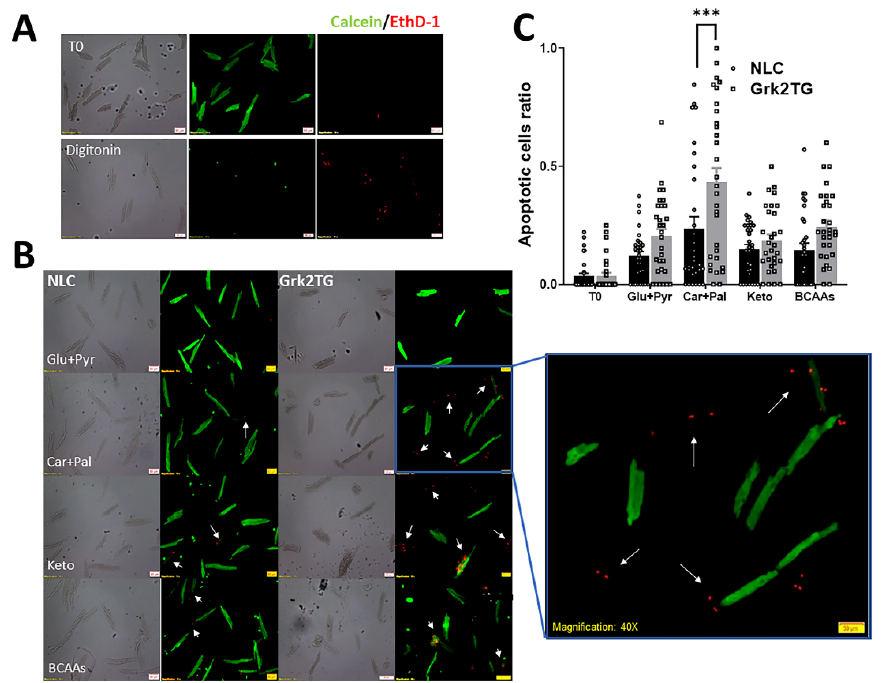
Figure 1. Upregulation of GRK2 in the myocyte enhances palmitate-driven cell death. ( A ) Digitonin treatment in ACMs induced cell death and labeling for EthD-1. Calcein-AM (green) labeled live